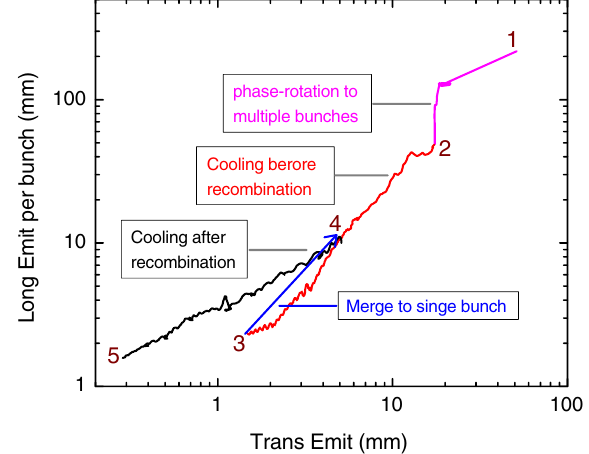
FIG. 7. End-to-end simulation plot of 6D cooling for a muon collider showing the evolution of the longitudinal emittance versus transverse emittance from the capture target to the end of 6D cooling.